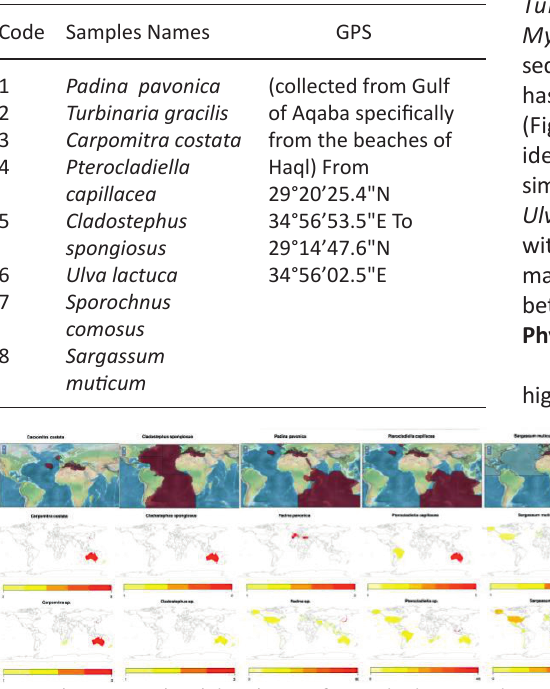
Fig. 2 . The geographical distribution for studied seaweed species as retived from AlgaeBase (above) and Genbank sequence information